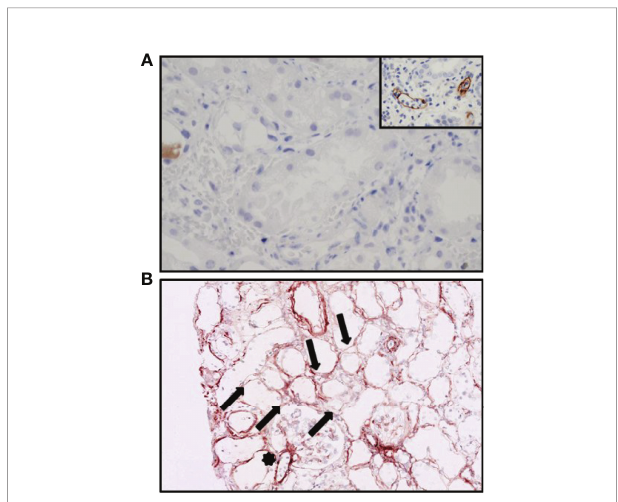
FIGURE 3 | Immunohistochemistry of the hyperacutely rejected allograft. (A) Staining for C4d showing no presence of C4d in the peritubular capillaries. The inset shows a positive control with acute humoral rejection. (B) C3d staining showing variable staining along the peritubular capillaries (arrows) and hilus of the glomerulus